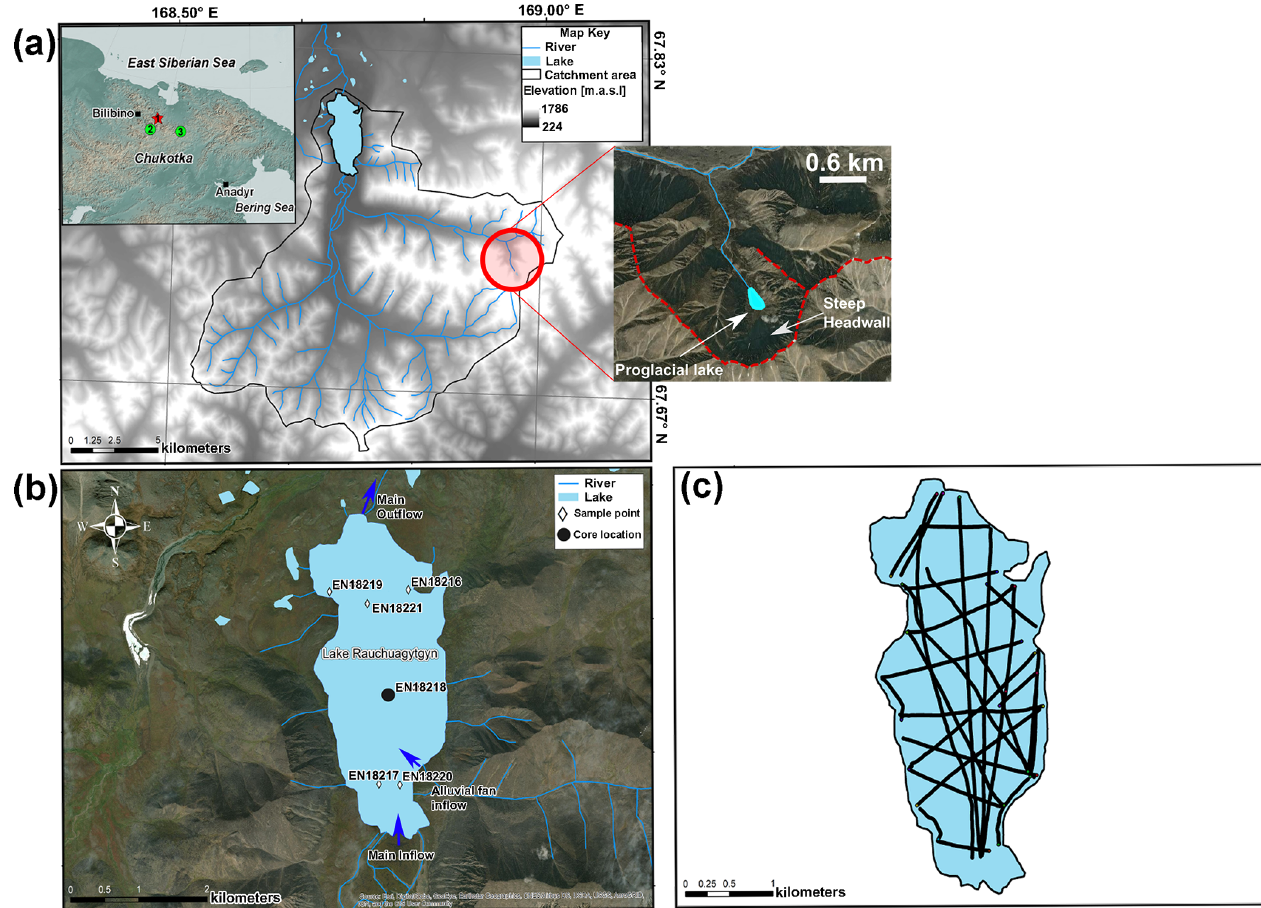
Figure 1. (a) Overview map of the Lake Rauchuagytgyn catchment plotted with a digital elevation map of the Anadyr mountains. The inset shows the situation of Lake Rauchuagytgyn (1) compared to other studied regional lakes: (2) Lake Ilirney and (3) Lake El’gygytgyn (ESRI 2020). A second inset shows the outline of a glacial cirque associated with a small proglacial lake within the eastern catchment. (b) Orthophoto map of the lake and surrounding features. Shown are the locations of surface sampling points and the location of sediment core EN18218 (black dot) as well as an alluvial fan at the lakes’ south-eastern margin (ESRI 2020). Flow directions of major inflow and outflow river systems are shown (blue arrows). (c) Lake polygon with all hydroacoustic profile paths retrieved during